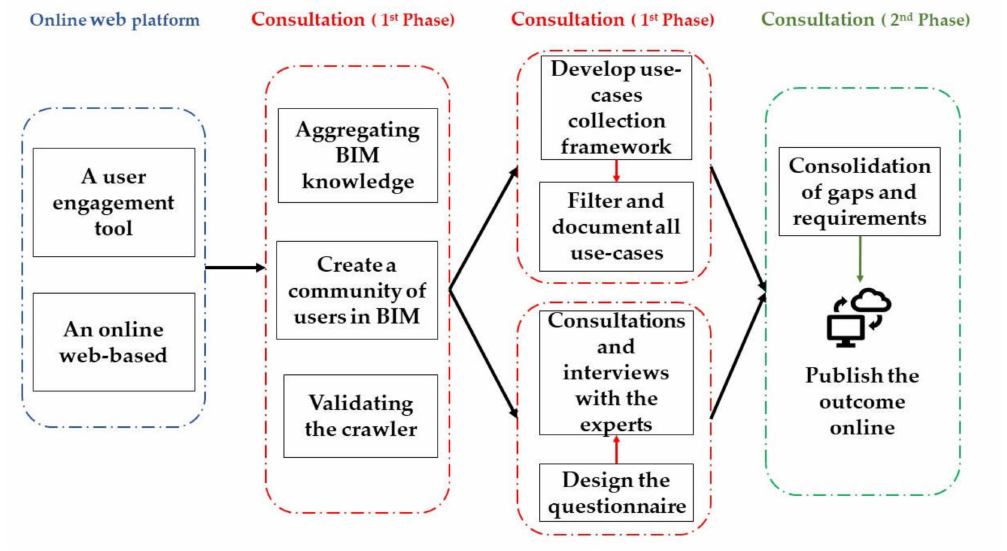
Figure 2. General requirements